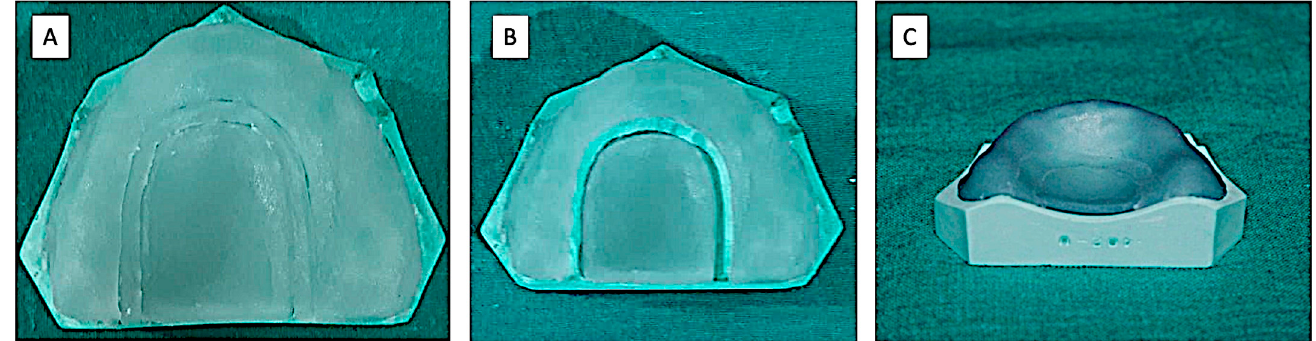
Figure 4. Record Base Fabricated by Technique-2 (Group-C). ( A ) The cut- below 15 mm from the alveolar ridge crest; ( B ) Fist components: a U-shaped segment along the residual ridge and ( C ) second component an elongated segment in the mid-palatal region